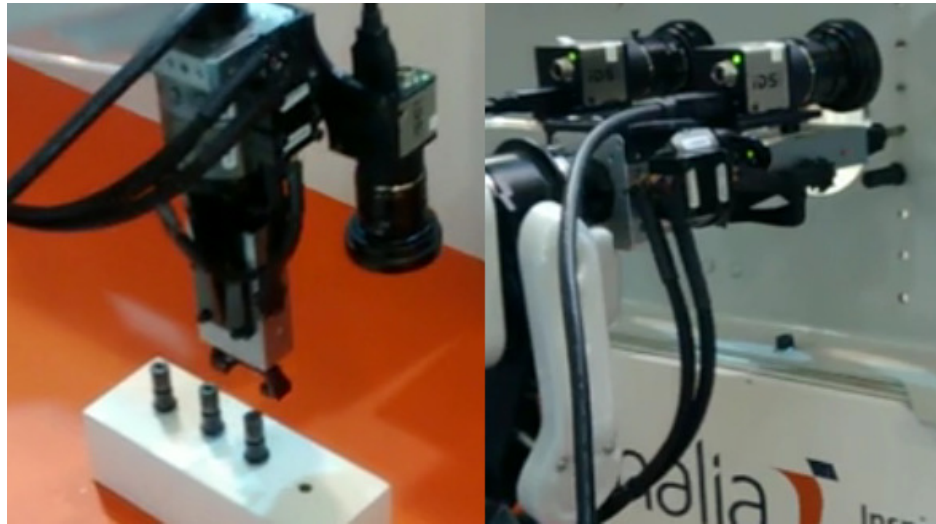
Figure 9. ( a ) The right arm of the robot is taking a rivet from a tray; ( b ) after taking the rivet, it is introduced in the previously-detected drilled